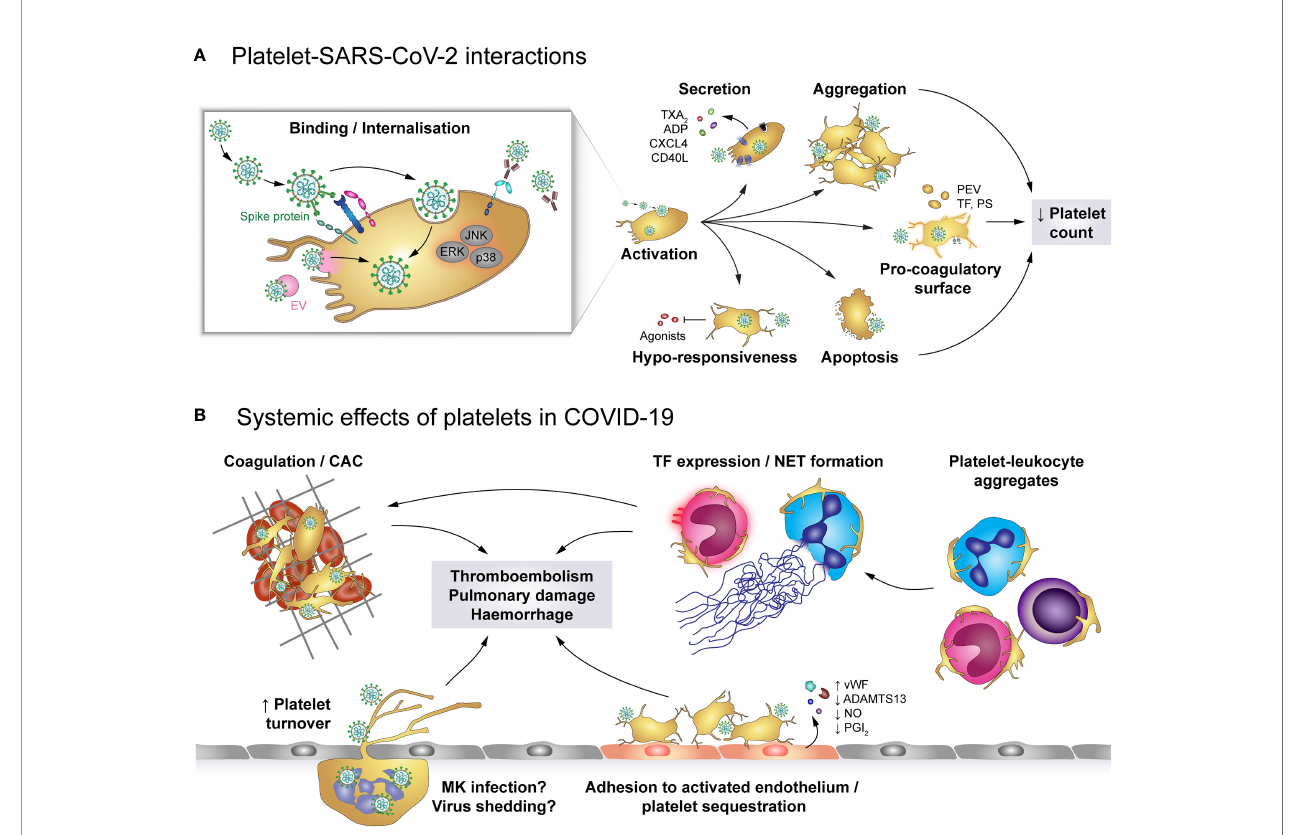
FIGURE 6 | The role of platelets in COVID-19. (A) SARS-CoV-2 may enter platelets upon binding to ACE2/TMPRSS2 or EMMPRIN receptors or by hitchhiking on extracellular vesicles (EV) that fuse with the platelet plasma membrane, though SARS-CoV-2-containing immune complexes are also recognised by Fc g RIIA. Binding and/or internalisation of SARS-CoV-2 stimulates platelet activation including degranulation and secretion, integrin activation and aggregation as well as exposure of pro-coagulant surfaces on platelets themselves or platelet-derived extracellular vesicles (PEV). Together with apoptosis of virus-bound platelets, these processes induce a reduction in circulating platelet count. Platelet hyper-activation in COVID-19 is accompanied by hypo-responsiveness to further stimulation. (B) Altered platelet behaviour in COVID-19 has systemic effects on pro-thrombotic and immunomodulatory platelet functions. Hyper-active and pro-coagulant platelets show enhanced adhesion to the in fl amed endotheliumand foster the development ofCOVID-19-associated coagulopathy(CAC). Accordingly, platelet turnover isincreased in COVID-19. Formation of platelet-leukocyte aggregates triggers monocyte TFexpression andNET formation,which add to the pro-coagulant microenvironment. In addition, infectedmegakaryocytes may shed virionsto exacerbate infection.Together, thesepathologicalterationsincrease the riskfor thromboembolisms, pulmonary damageand haemorrhages. ACE2, Angiotensin-convertingenzyme 2; ADP, adenosine diphosphate; ADAMTS13, A disintegrin and metalloproteinasewith a thrombospondintype1 motif, member 13; CAC, COVID-19-associated coagulopathy; CD40L, CD40 ligand; COVID-19, Coronavirus-induceddisease 2019; CXCL4, chemokine (C-X-C motif) ligand 4; EMMPRIN, extracellular matrix metalloproteinaseinducer; ERK, Extracellular signal-regulatedkinase; Fc g RIIA, Immunoglobulin g Fc region receptor IIA; JNK, c-Jun N-terminalkinase; p38, p38 mitogen-activatedprotein kinase; MK, Megakaryocyte; EV, Extracellular vesicle; NET, neutrophilextracellular trap; PEV, Platelet-derived extracellular vesicle; NO, Nitric oxide; PGI 2 , ProstaglandinI 2 (prostacyclin);PS, phosphatidylserine; SARS-CoV-2, Severe acute respiratorysyndrome coronavirus 2; TF, Tissue factor; TMPRSS2, Transmembrane protease serine subtype 2; TXA 2 : thromboxane A 2 ; vWF,von Willebrand